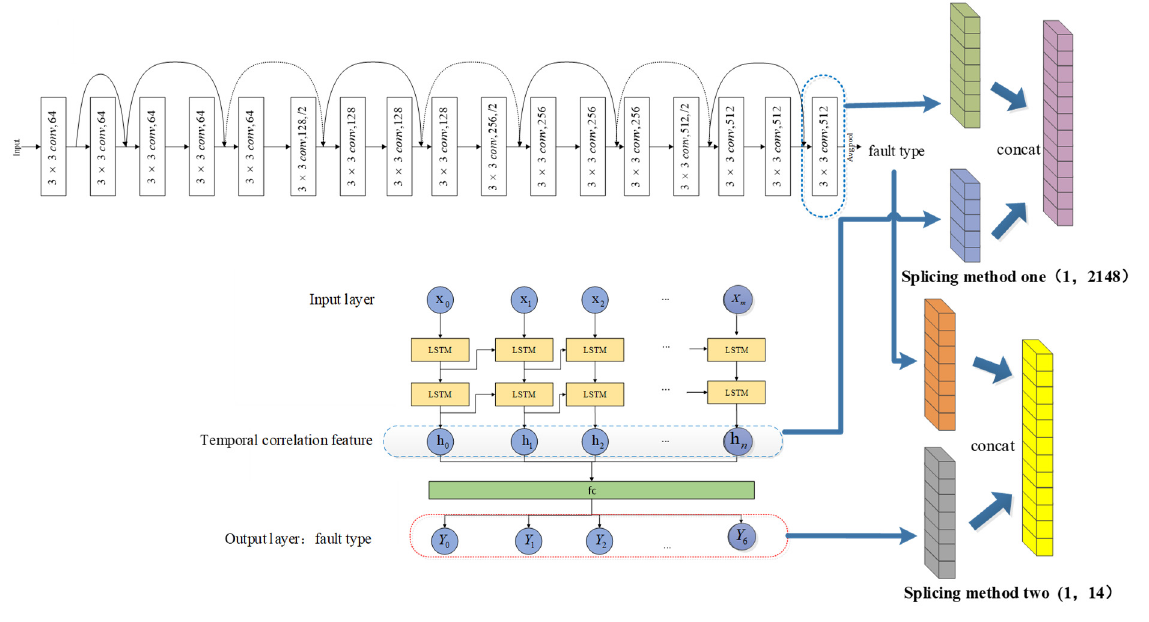
Figure 16. Feature splicing.